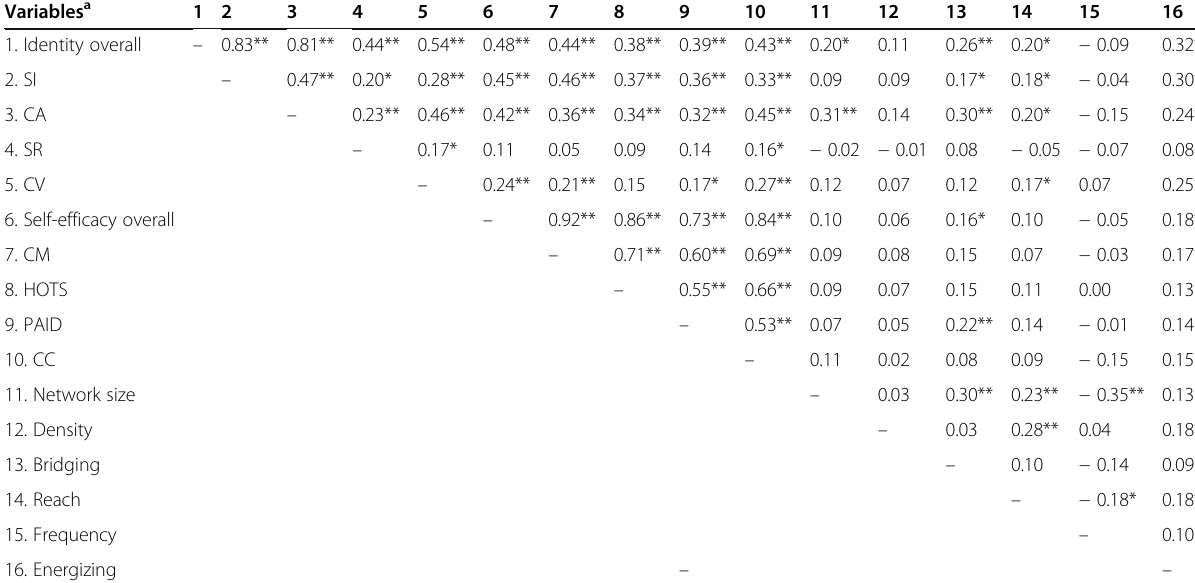
Table 7 Spearman correlations among science and math identity, self-efficacy, and CoP network characteristics Variables